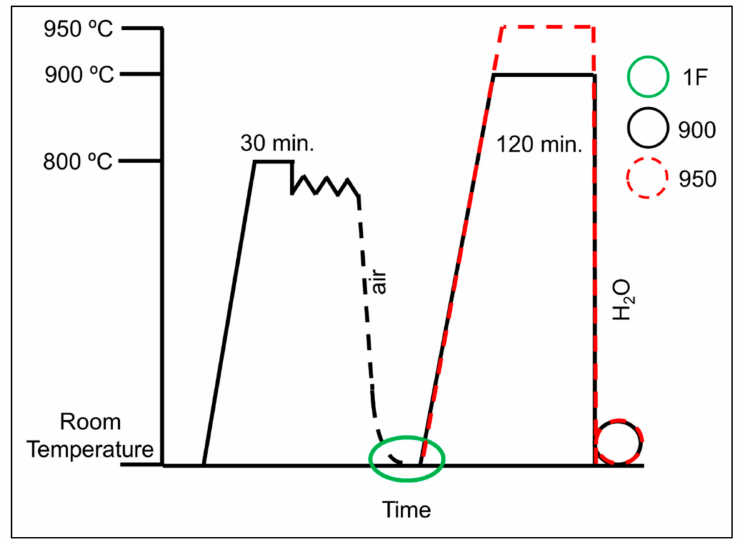
Figure 1. Scheme of the thermomechanical processing and subsequent solution heat treatment explored in this study.